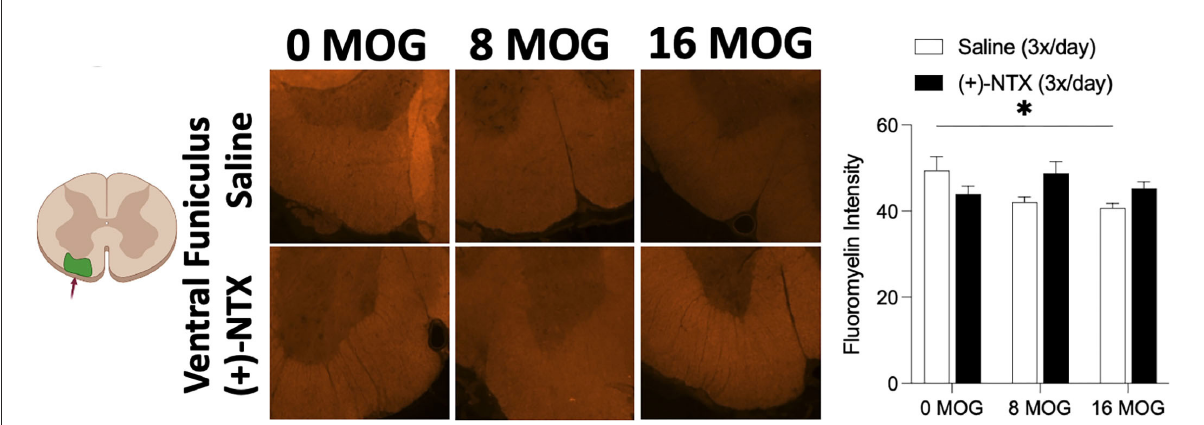
FIGURE10 Myelin oligodendrocyte glycoprotein (MOG) induces lumbar spinal ventral funiculus demyelination. Sprague-Dawley (SD) from Experiment 2 received intradermal low-dose (0, 8, and 16 µ g) myelin oligodendrocyte glycoprotein (MOG). Spinal cord tissue was collected on day 30 post-MOG administration and during 13 days of daily ( + )-NTX administration. Only the 16- µ g dose of MOG significantly decreased fluoromyelin staining intensity of ventral funiculus of lumbar spinal cord; however, this was not significantly reversed by ( + )-NTX administration. Significant interaction between MOG and ( + )-NTX treatment [ F (2,151) = 5.89; p < 0.01]. N = 5–8/group with 2–8 pictures analyzed per subject. Post-hocs : * indicates significant differences between groups (* p <